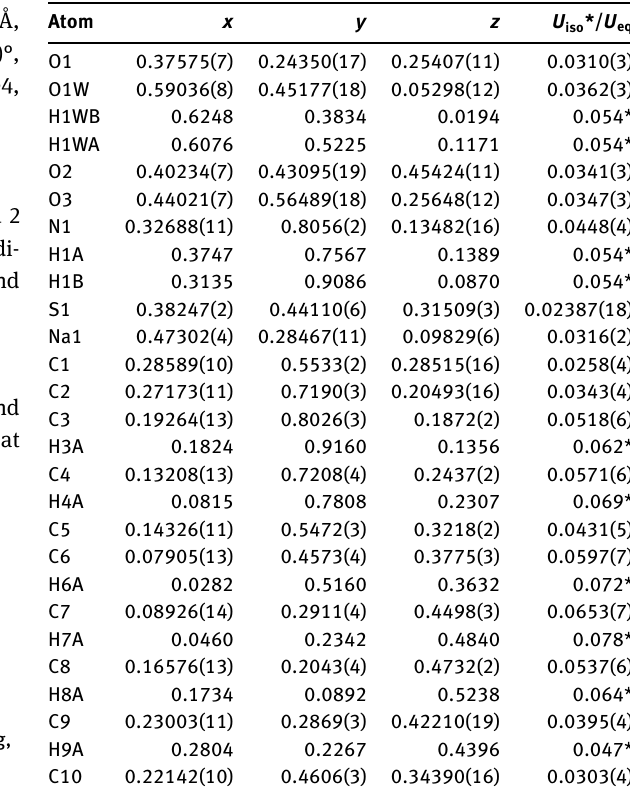
Table 2: Fractional atomic coordinates and isotropic or equivalent isotropic displacement parameters (Å 2